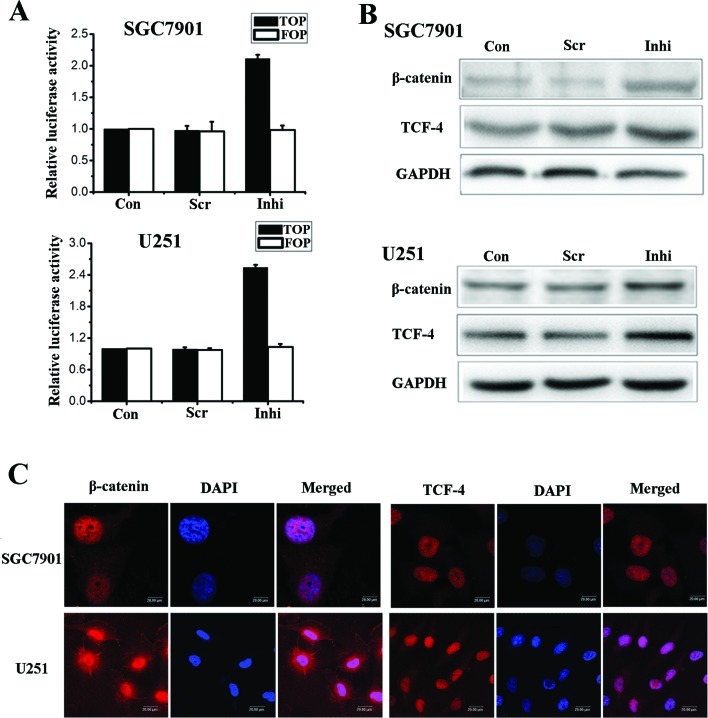
Modulation of the Wnt/β-catenin signaling pathway by miR-200a inhibitor in SGC7901 and U251 cells. (A) Knockdown of miR-200a expression resulted in the induction of TopFlash luciferase activity, indicating the transcriptional activity of the β-catenin/TCF complex. Knockdown of miR-200a expression had no effect on FopFlash luciferase activity. (B) Western blot analysis of β-catenin and TCF-4 in cells treated with miR-200a inhibitor. (C) Lower levels of miR-200a cause nuclear accumulation of β-catenin in both SGC7901 and U251 cells, while levels of TCF-4 increased in the nucleus compared to control vector.